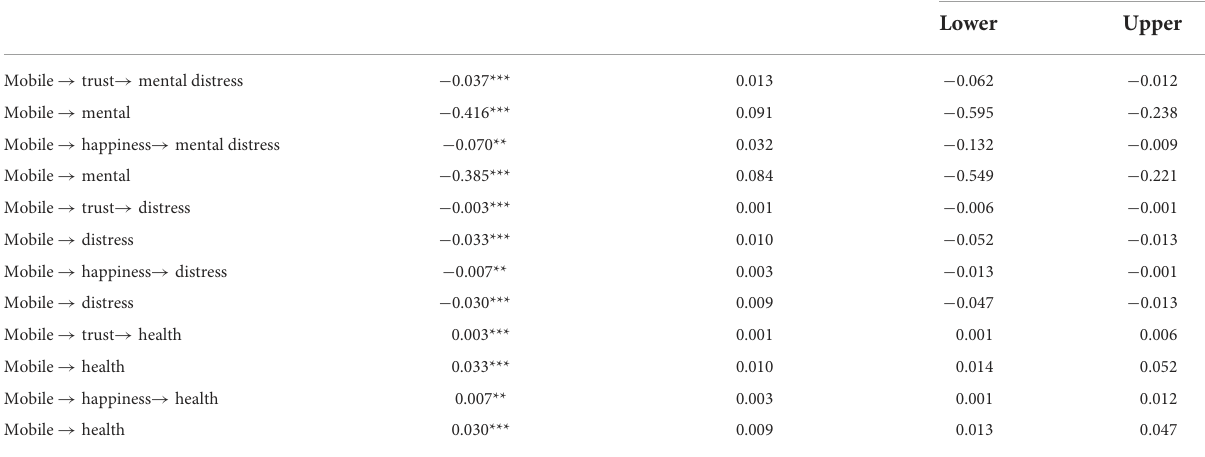
TABLE 7 Result of media effect.